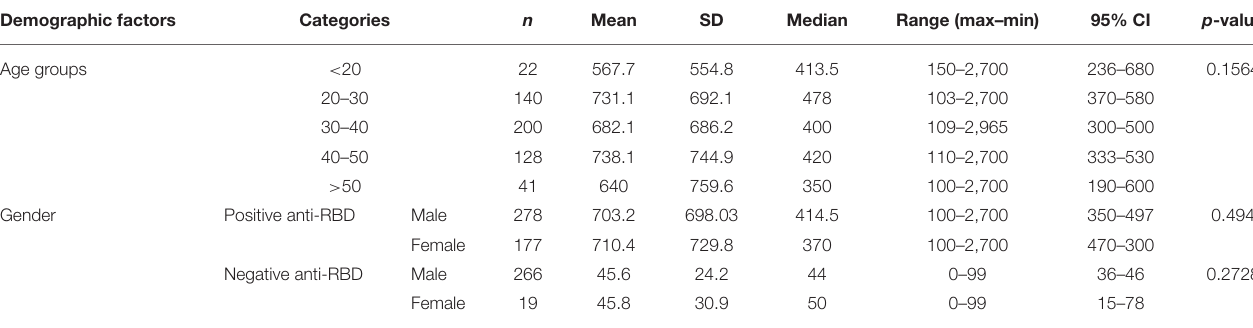
TABLE 3 | Demographic factors and statistical parameters of individuals included in this study.